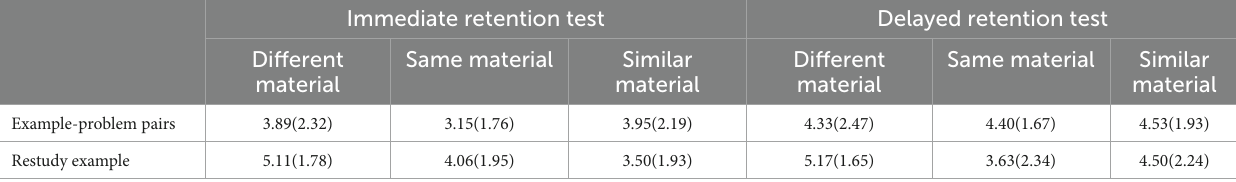
TABLE 3 The effect of retrieve practice on problem-solving under different material